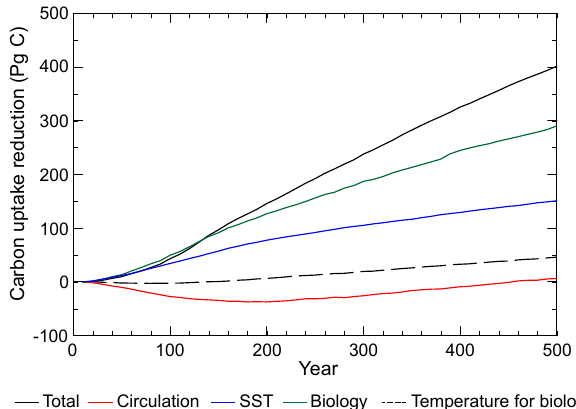
Figure 8. Time series of the contributions of primary mechanisms to the reduction in the oceanic CO 2 uptake in the CTL-base and GW-base experiments. The positive and negative values represent uptake increases and decreases, respectively. The contributions of circulation (red), biology (green), and SST (blue) and the tempera- ture dependences of production and remineralization (black dashed line) are illustrated. The quantification methods for each mechanism are summarized in Table